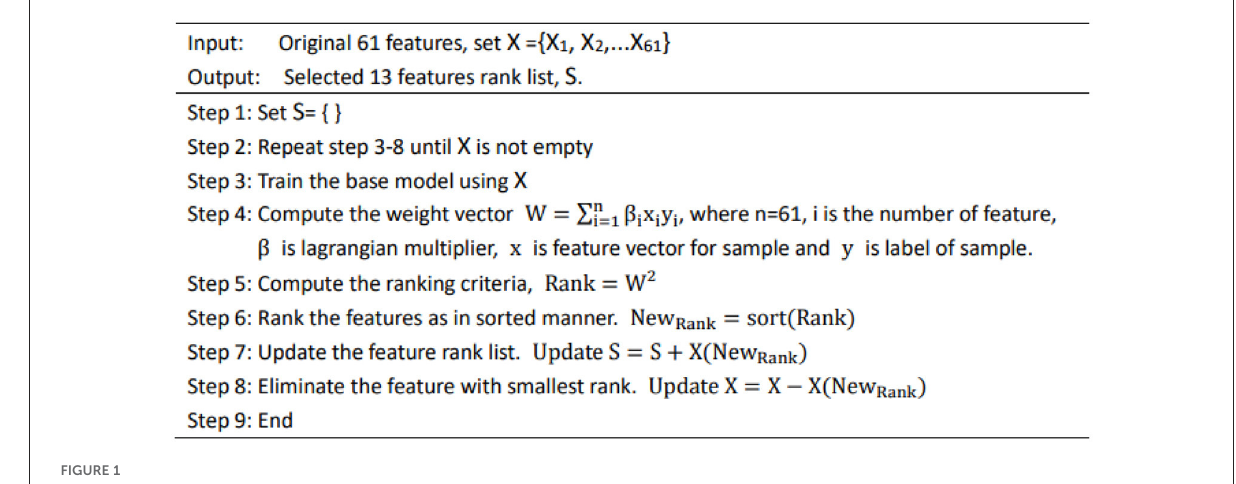
FIGURE1 Feature selection algorithm.